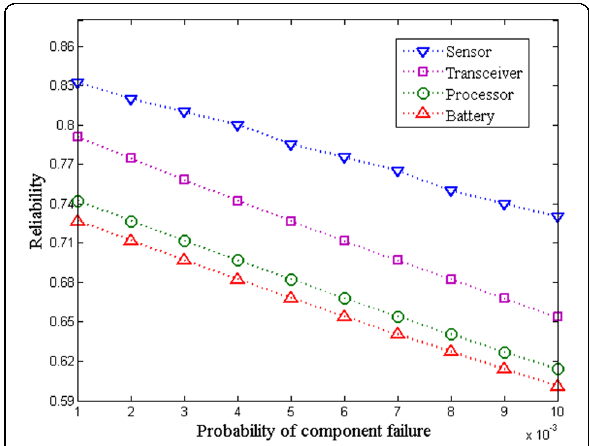
Fig. 7 Reliability R ( S ) for the deployment S3-D1 in Table 4 at different probabilities of failure of the sensor, transceiver, processor, and battery, assuming all deployed SNs are of type